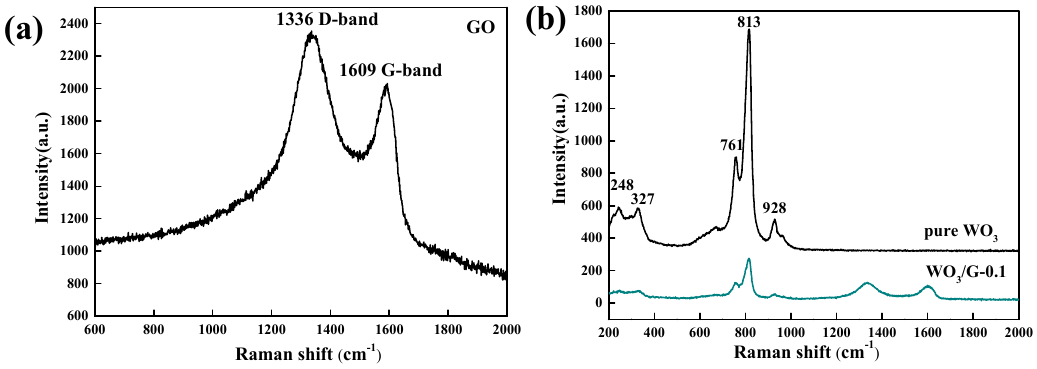
Figure 2. Raman spectra of: ( a ) GO; and ( b ) pure WO 3 and WO 3 /GR-0.1 nanocomposite.